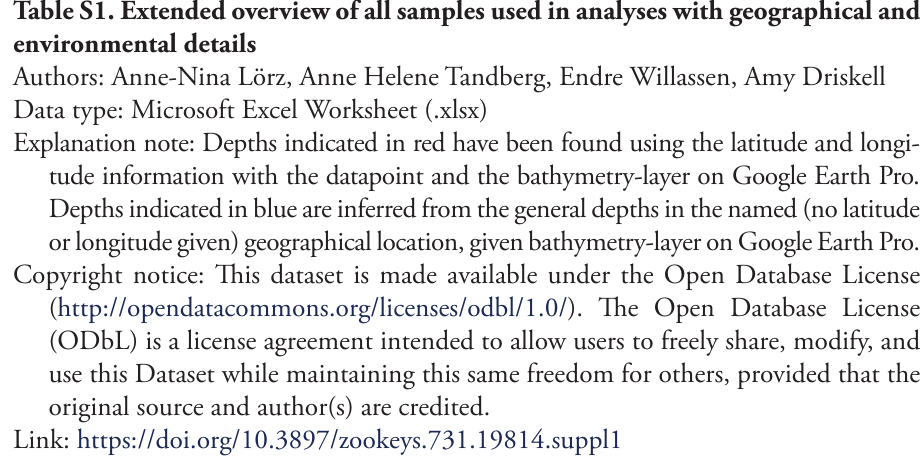
Table S1. Extended overview of all samples used in analyses with geographical and